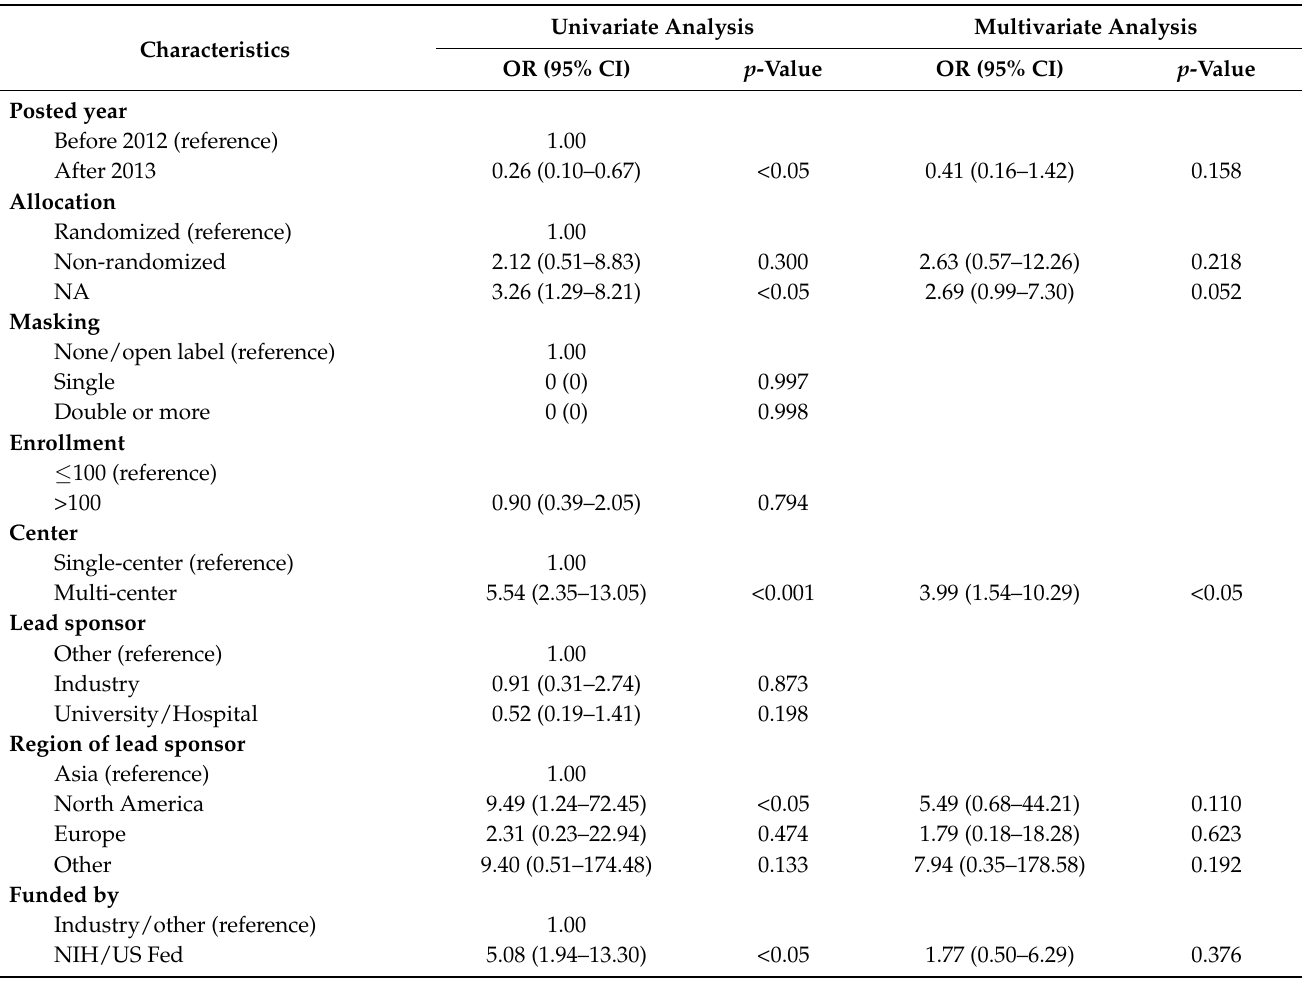
Table 4. Adjusted logistic regression analysis of the association of characteristics with results